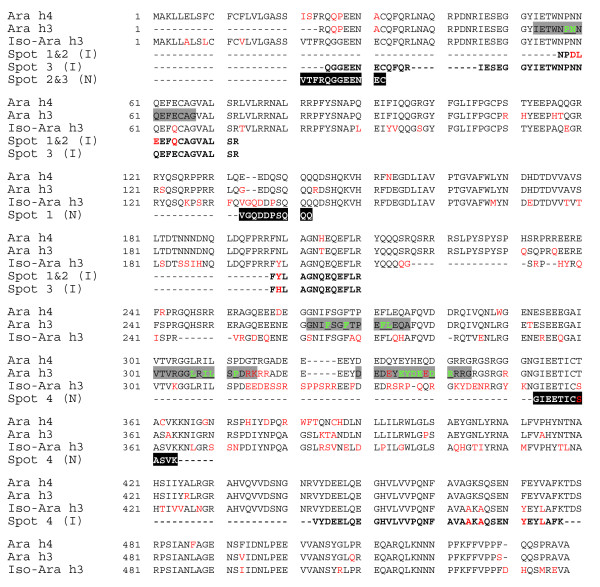
Amino acid sequences alignment. Amino acid sequences alignment of peptide sequences (N = N-terminal sequences; I = internal sequences by using in-gel trypsin digestion and sequencing), in bold-faced, of spots 1–4 with the published peanut allergen sequences of Ara h4 (AAD47382), Ara h3 (AAC63045), and iso-Ara h3 (ABI17154) (26). Sequences obtained by N-terminal sequencing are shaded in black. The different amino acid residues are colored in red. The amino acid sequences of Ara h3 IgE-binding epitopes [24] are shaded in gray and the critical amino acids to IgE binding are colored in green and underlined.